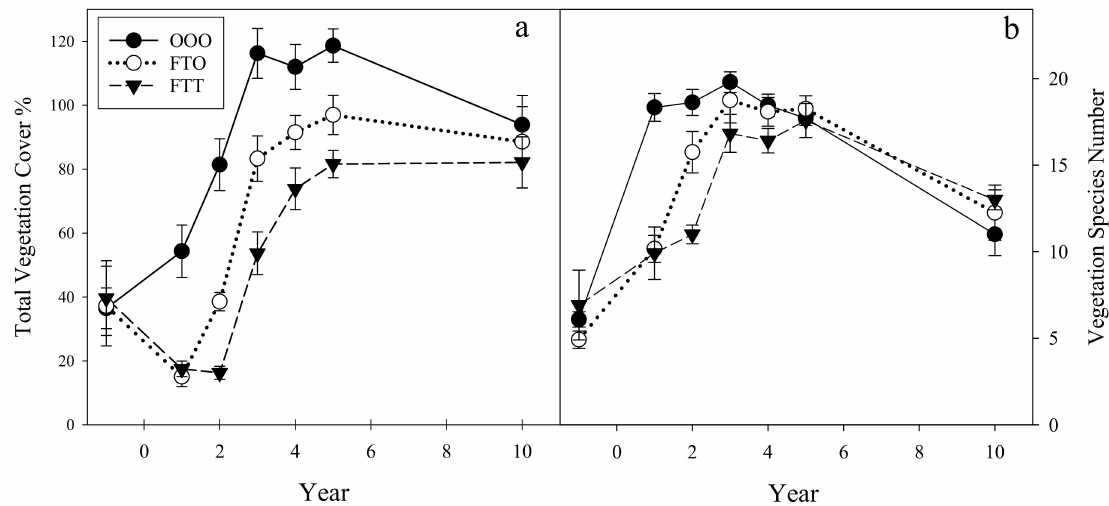
Figure 1. Forest vegetation management treatment regime e ff ect on: ( a ) development of summed vegetation cover over time, and ( b ) changes in the average number of species per plot over time. Treatment descriptions are provided in Table 1.